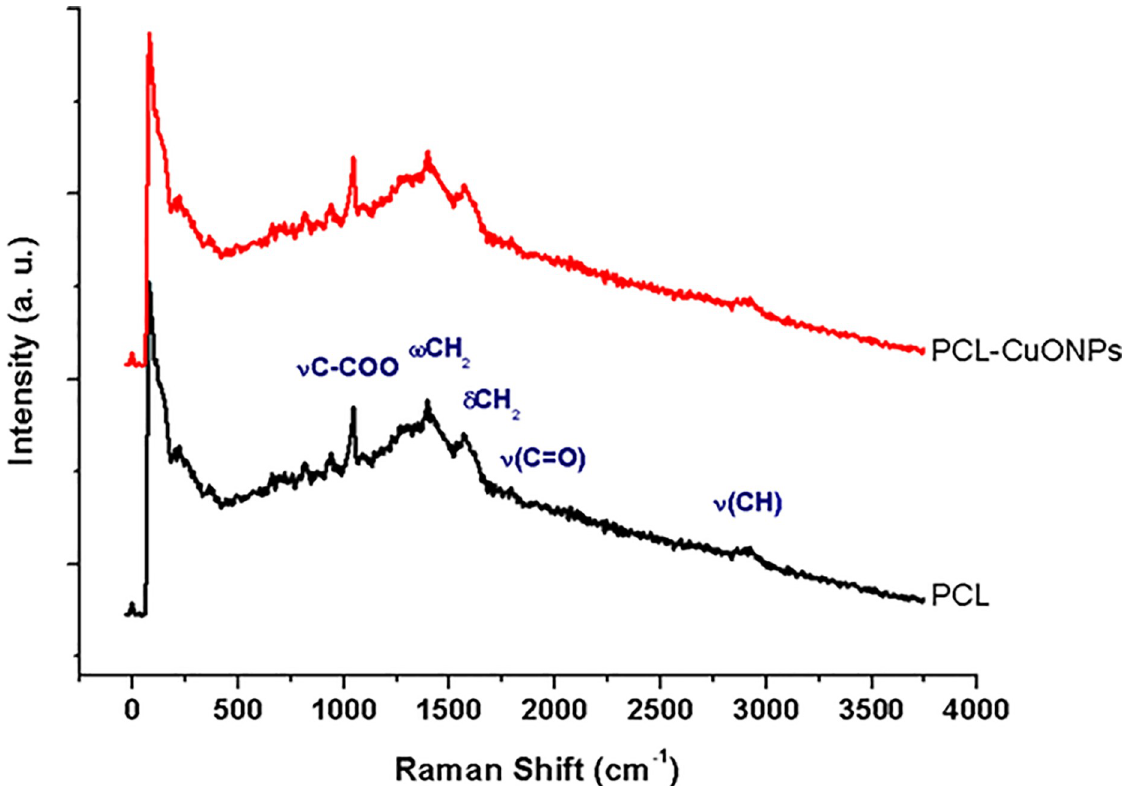
Fig 2. Raman spectra of PCL and PCL-CuONPs fibers.